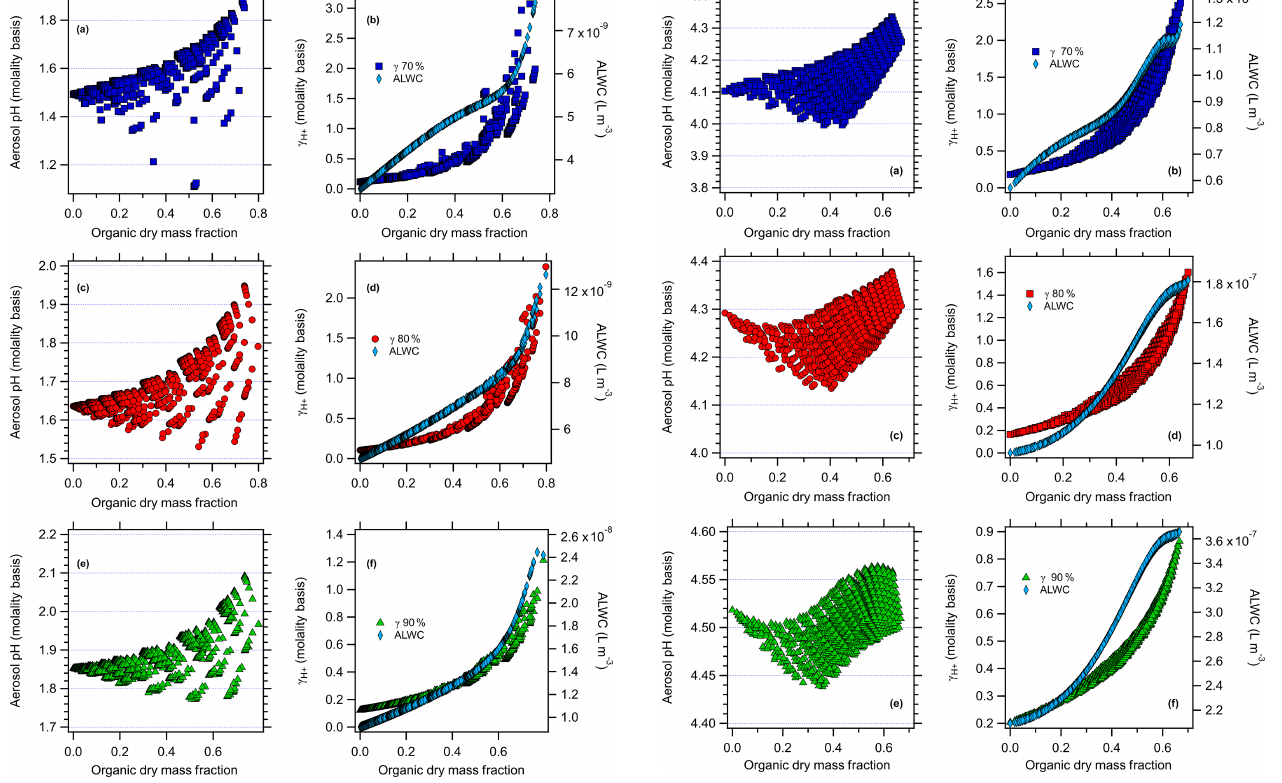
Figure 2. AIOMFAC-modeled aerosol pH (molality basis) versus organic dry mass fraction with the factorial addition of nonacid or- ganic species and AIOMFAC-modeled γ H + (molality basis) and aerosol liquid water (ALW, polynomial fit to AIOMFAC output) versus organic dry mass fraction (right panel) for Baltimore at (a, b) 70% RH, (c, d) 80% RH, and (e, f) 90% RH.